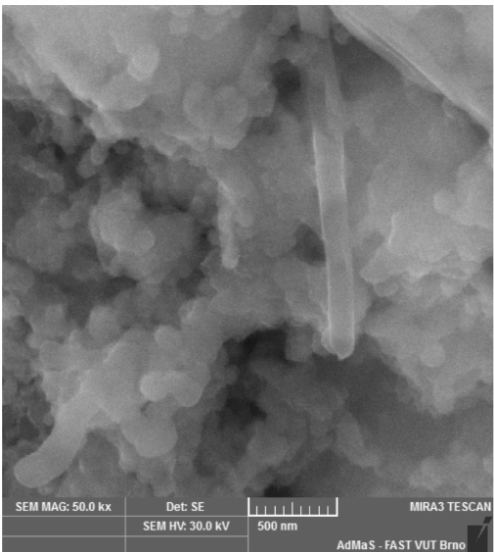
Figure 3. Morphology of cement hydration products with nanotubes at the induction period of hydration (about 1 hour after cement paste mixing).